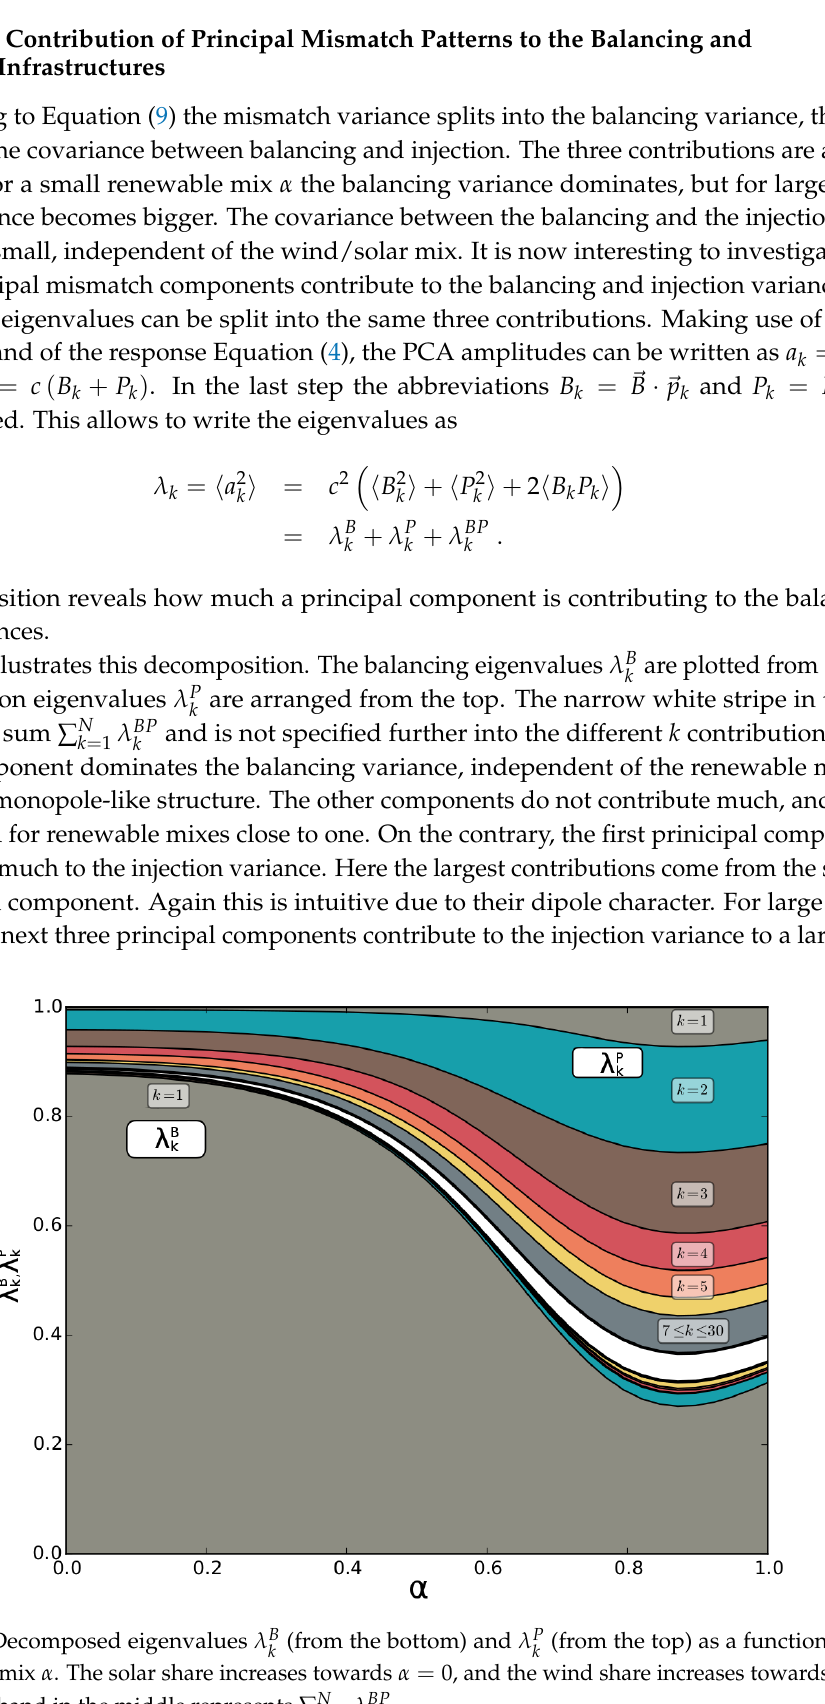
(from the bottom) and λ P (from the top) as a function of the k k λ BP k = 1 k